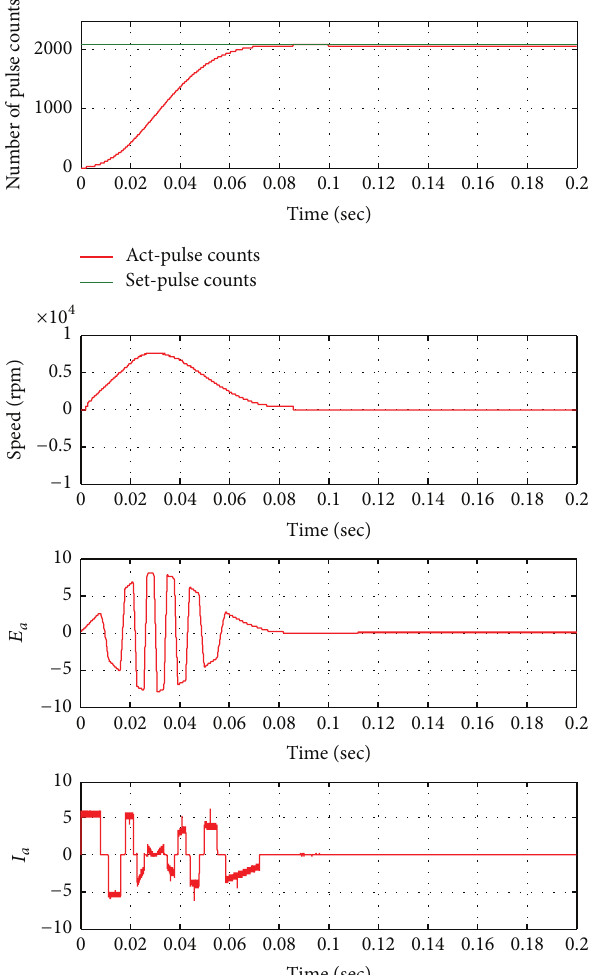
Figure 9: Position response of PID controller based control actua- tion system for 2100 counts.